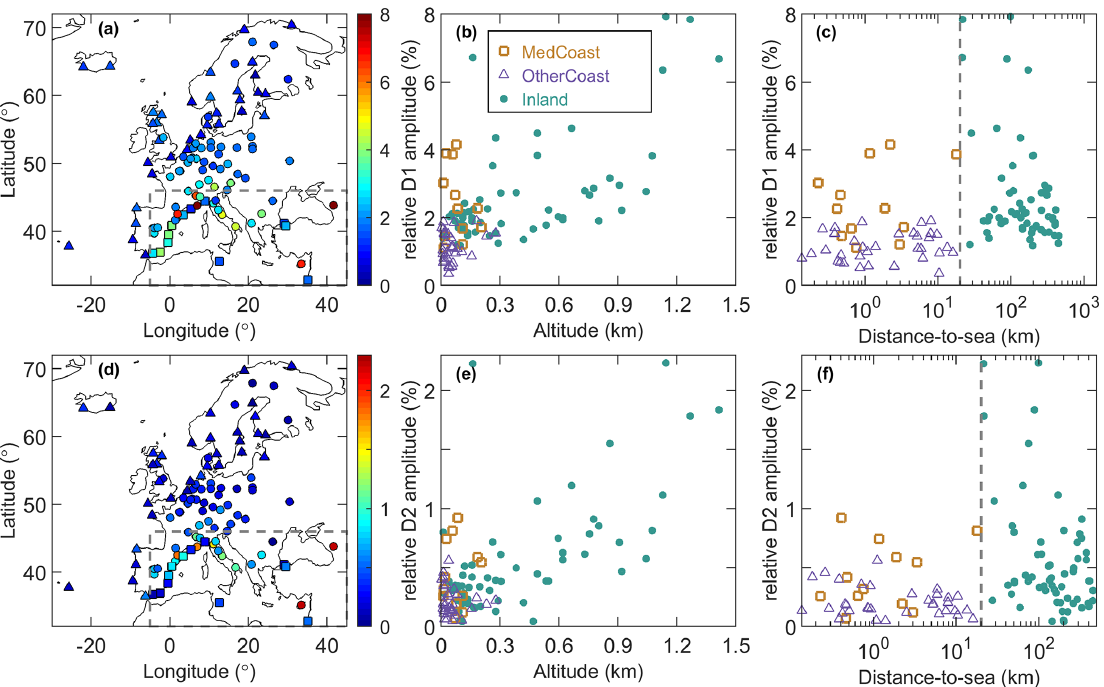
Figure 7. (a) Relative amplitudes of the first harmonic ( D 1 ) of the diurnal GPS IWV cycle. Panels (b) and (c) are the variations of the relative D 1 amplitudes with respect to station altitude and distance to sea, respectively. Panels (d) – (f) are the same as panels (a) – (c) but for the second harmonic ( D 2 ). The stations are classified into three types, namely Inland, MedCoast, and OtherCoast. The type of Inland includes 62 stations with their distance to sea (SeaDist) no shorter than 20km. The type of MedCoast contains 12 stations located at the coastal region of the Mediterranean (SeaDist < 20km; 32 ◦ N < lat < 46 ◦ N, 45 ◦ E < long < 5 ◦ W). The rest of the 34 stations are classified as OtherCoast.